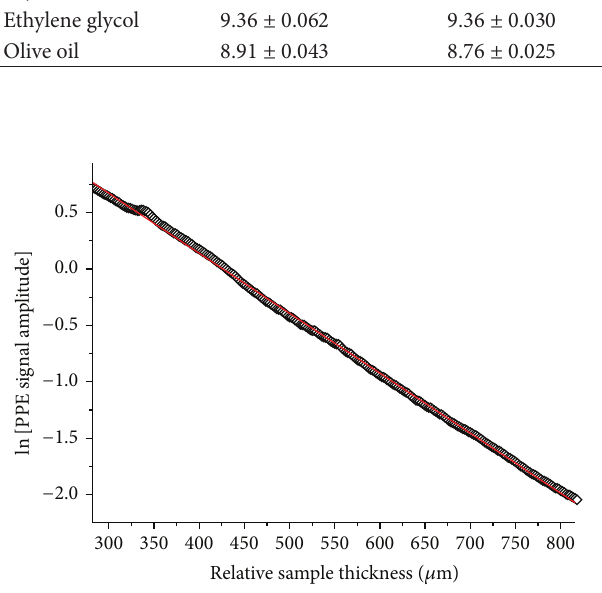
Figure 4: PPE signal amplitude as a function of the cavity length, having water as a sample and PLZT ceramic as PE detector; the solid line represents the best fitting of (2) to the experimental data.